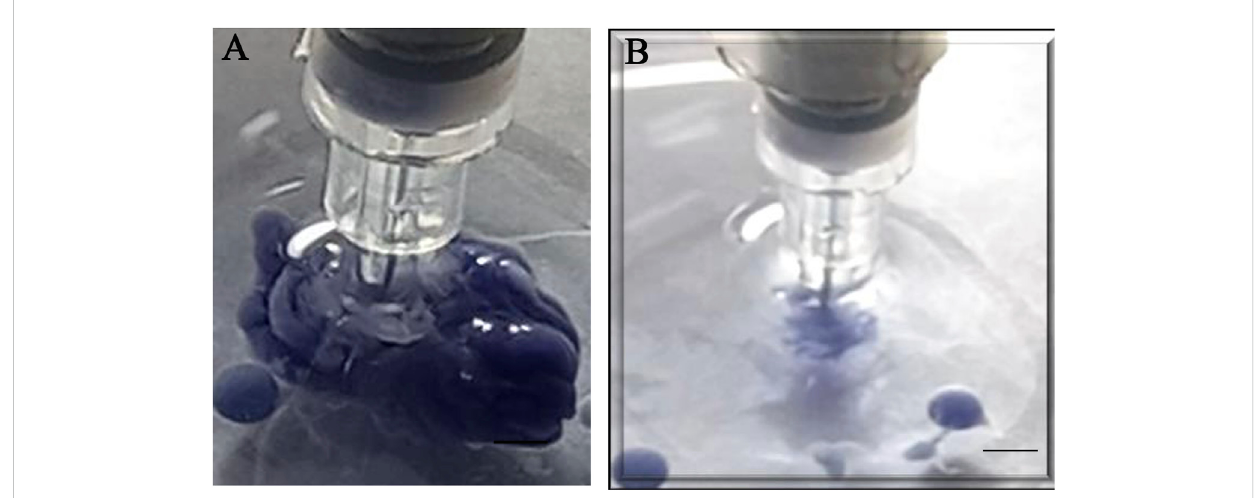
FIGURE 9 Representativeimagesoftheproblemscausedbyalginategeli fi cationinsuf fi ciency: (A) Excessextrudedalginate, (B) Lackofextrudatedalginatedue to needle stickiness. Scale bar: 1